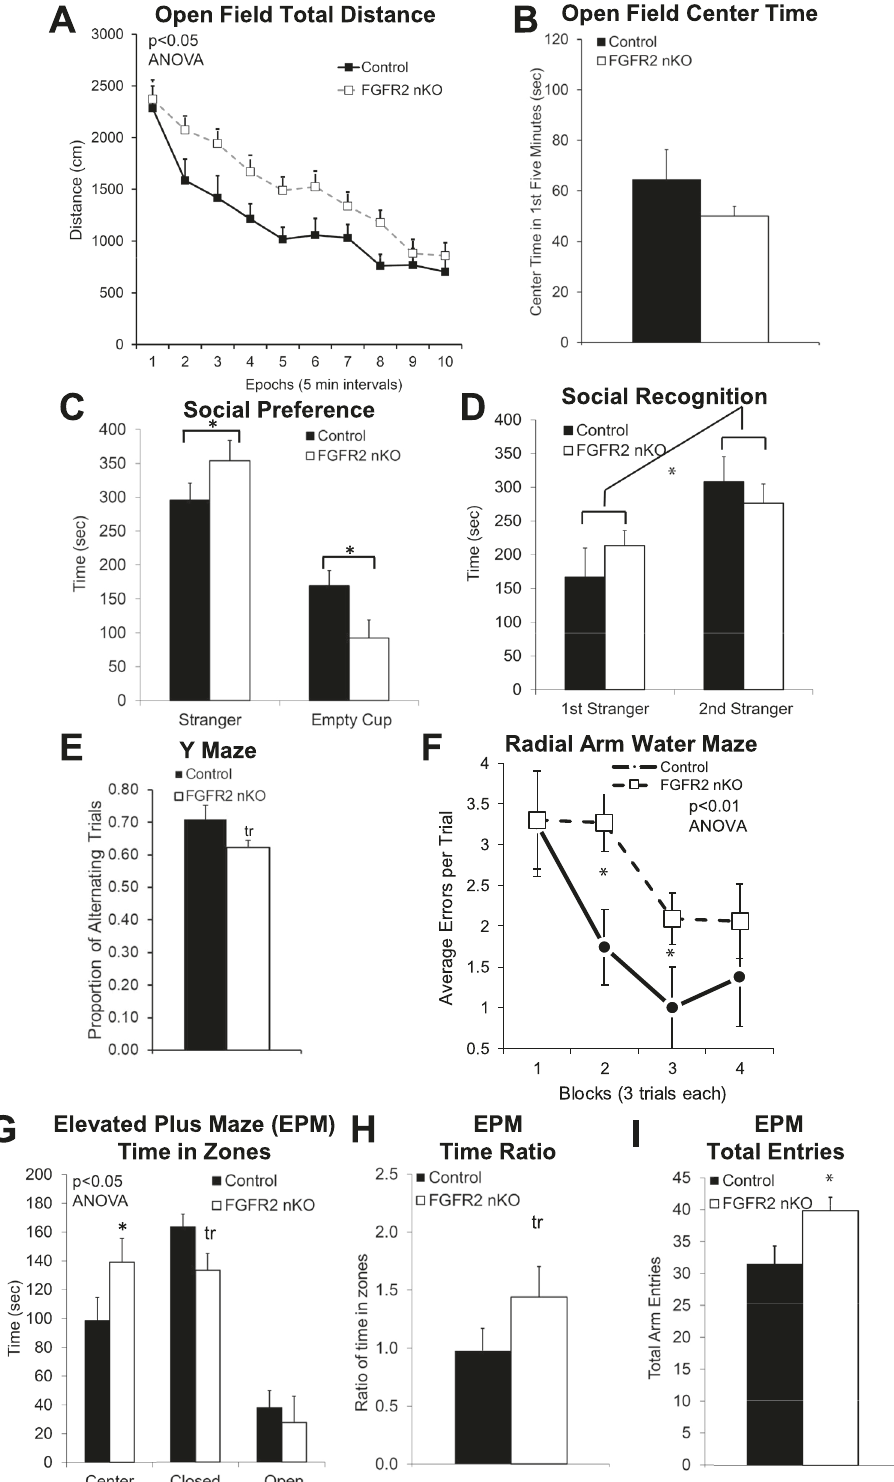
Fig. 2 Adult male mice early postnatally lacking FGFR2 driven by GFAP- CreER T2 (induced with neonatal tamoxifen injections P1-7) showed locomotor hyperactivity, reduced anxiety-like behavior, increased sociability, and reduced working memory. A Persistently increased distance traveled in the open fi eld in FGFR2 nKO mice. B No differences in anxiety-like behavior with open fi eld time in the center. C Three chamber social task with social side compared with non-social side showed increased social preference in FGFR2 nKO mice. D Three chamber social task with familiar social side compared with novel social side showed no differences in social recognition. E Reduced working memory with less Y maze spontaneous alternation in FGFR2 nKO mice. F Reduced working memory with increased errors in the Radial Arm Water Maze training trials in FGFR2 nKO mice. G Reduced anxiety-like behavior with altered time spent in the closed and center arms of the EPM. H Reduced anxiety-like behavior with altered ratio of time in zones of the EPM. I Increased locomotor activity with increased overall entries into all arms of the EPM. N = 10,10; * p < 0.05 two-tailed Student ’ s t -tests or ANOVA. Means and SEM